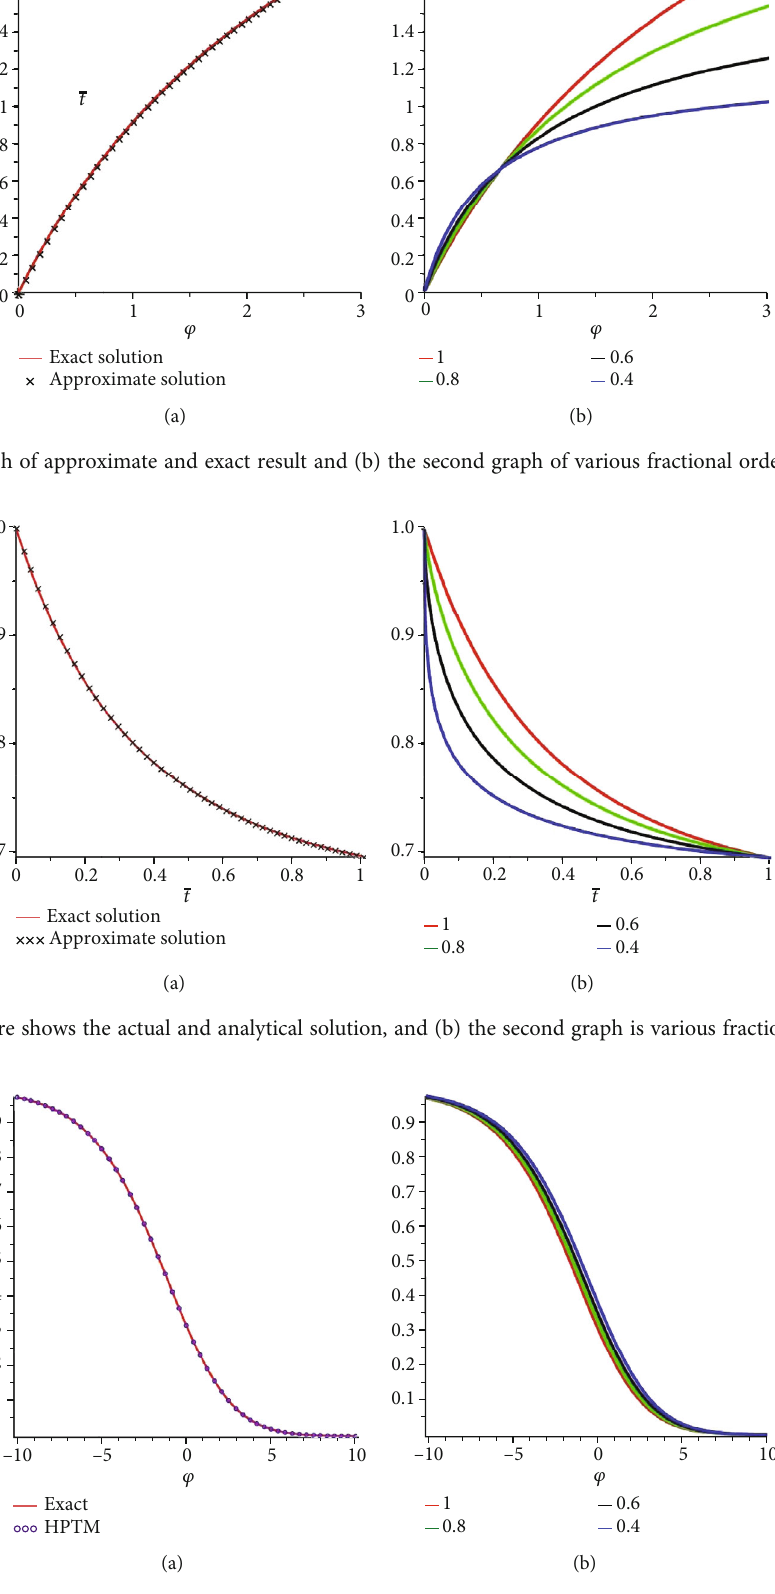
Figure 3: (a) The fi rst graph of actual and analytical solution and (b) di ff erent fractional order of β of Case 2.